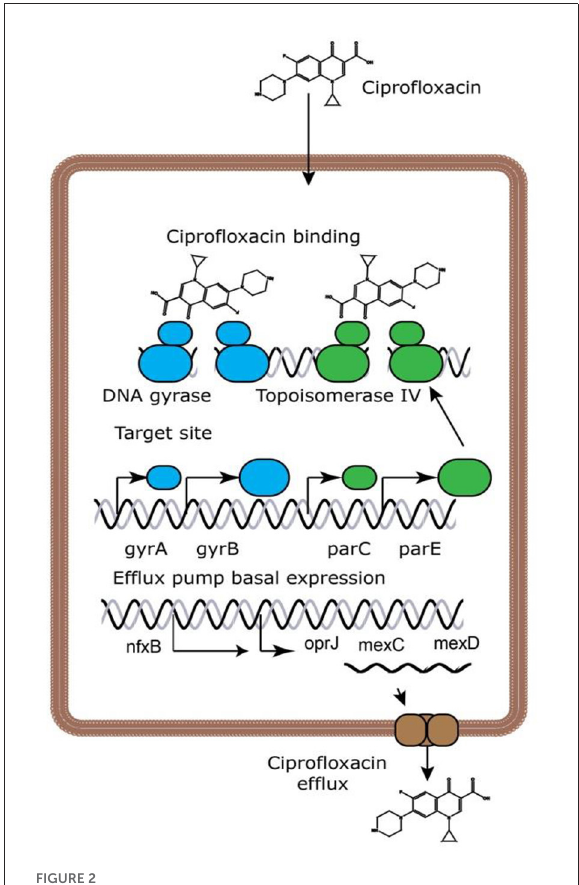
FIGURE2 Ciprofloxacin’s mechanisms of action (13).